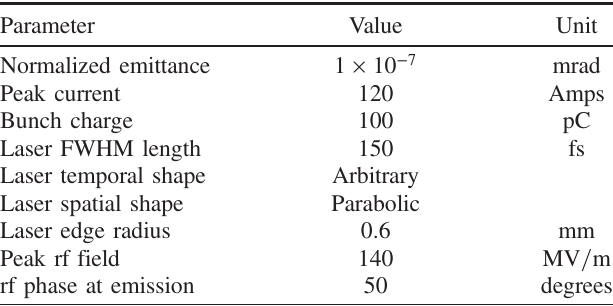
TABLE II. Cathode laser and initial electron beam parameters.